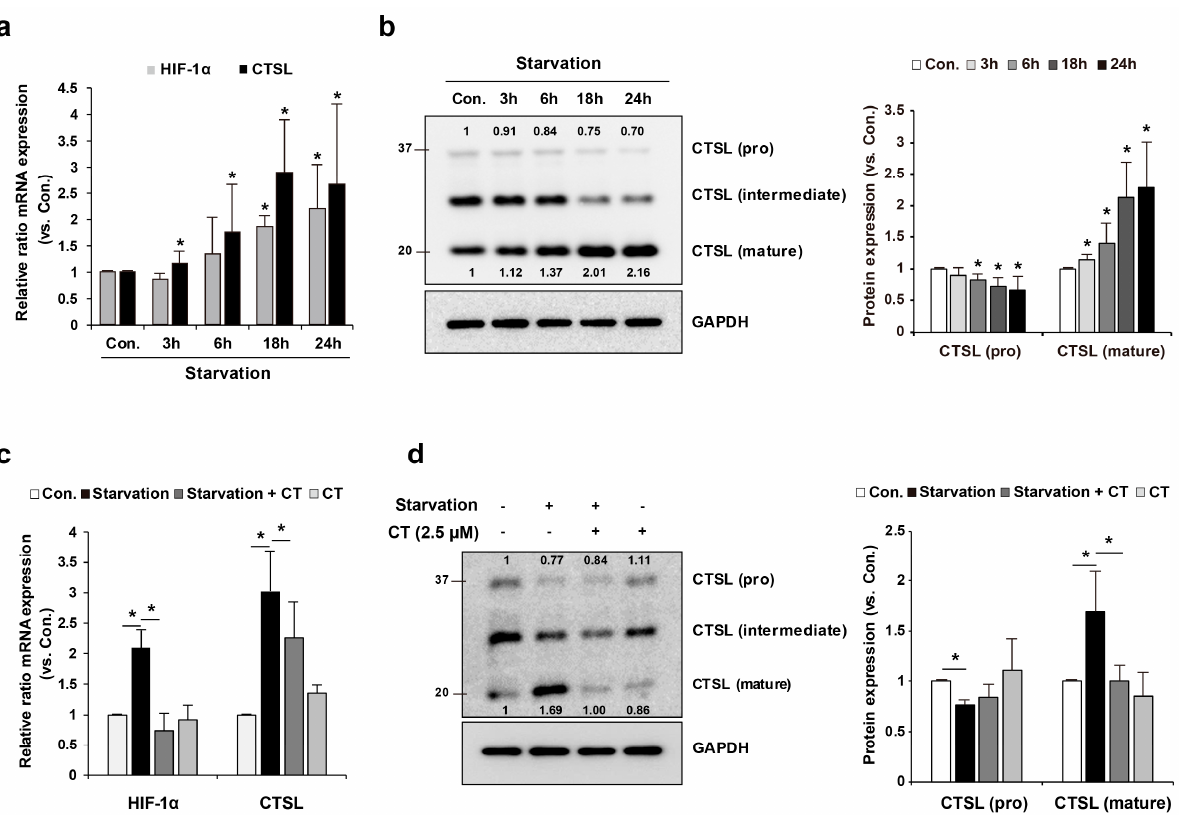
Figure 2. HIF-1 α and CTSL induction was enhanced by starvation condition in melan-a cells. ( a ) mRNA levels of HIF-1 α and CTSL were evaluated under starvation control. Moreover, ( b ) the protein level of CTSL was examined. Melan-a cells were pretreated with CT for 1 h and ( c ) mRNA levels of HIF-1 α and CTSL were determined under starvation for 24 h. ( d ) Protein level of CTSL was also confirmed. Results are expressed as mean ± S.D of more than three independent experiments. * p < 0.05. Student’s t -test.